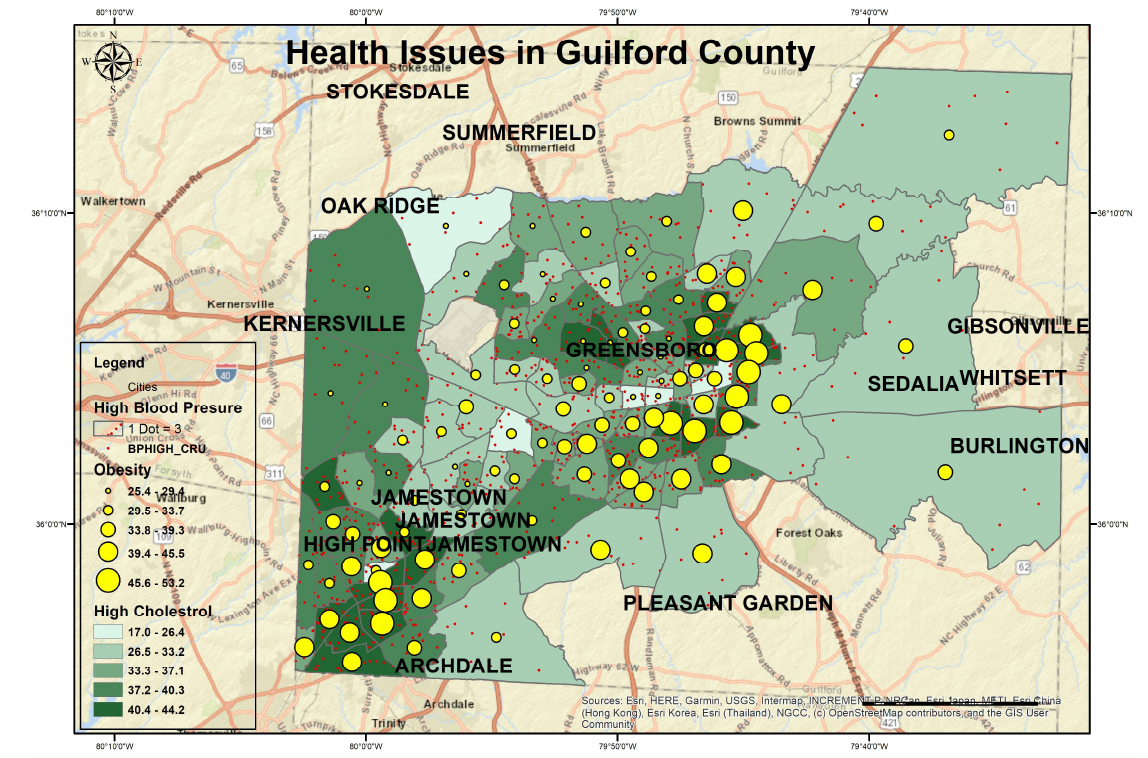
Figure 3. The distribution of health issues (i.e., high cholesterol, hypertension, and obesity) in Guilford County. Figure 3.